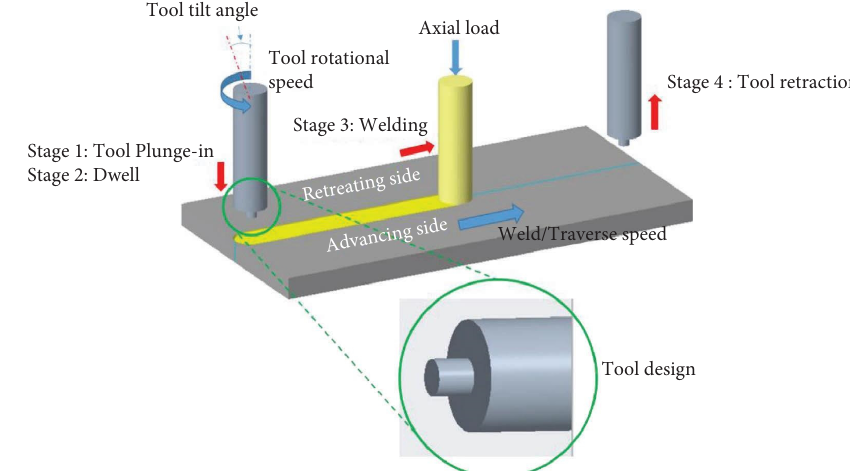
Figure 3: Schematic illustration of the FSW process depicting various stages of operation and process parameters.